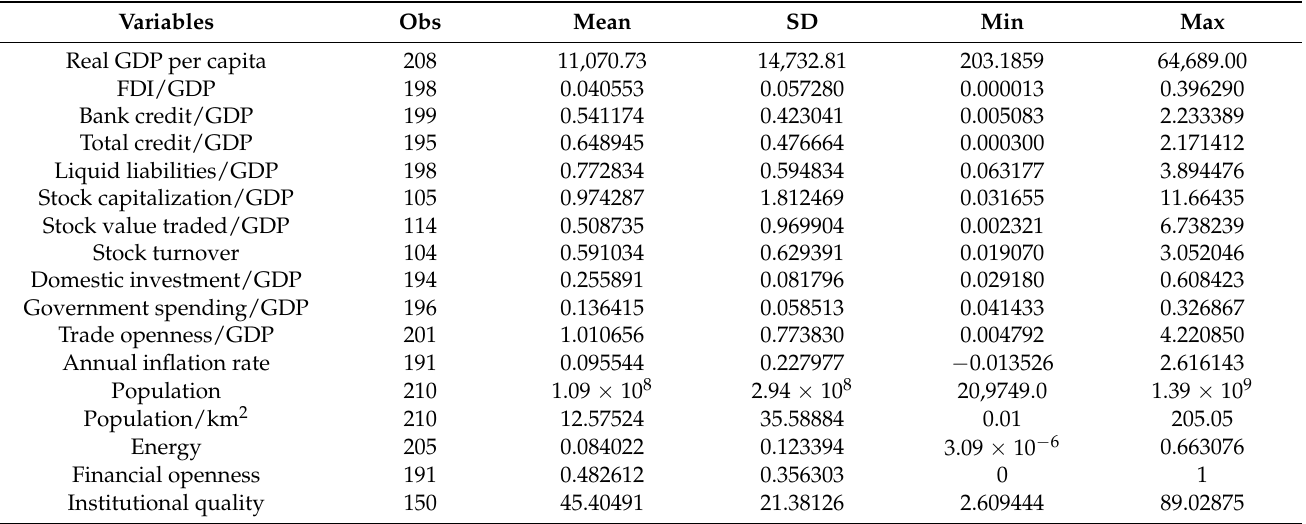
Table 2. Descriptive statistics with five year average unbalanced panel data of 30 ADC economies (1986 to